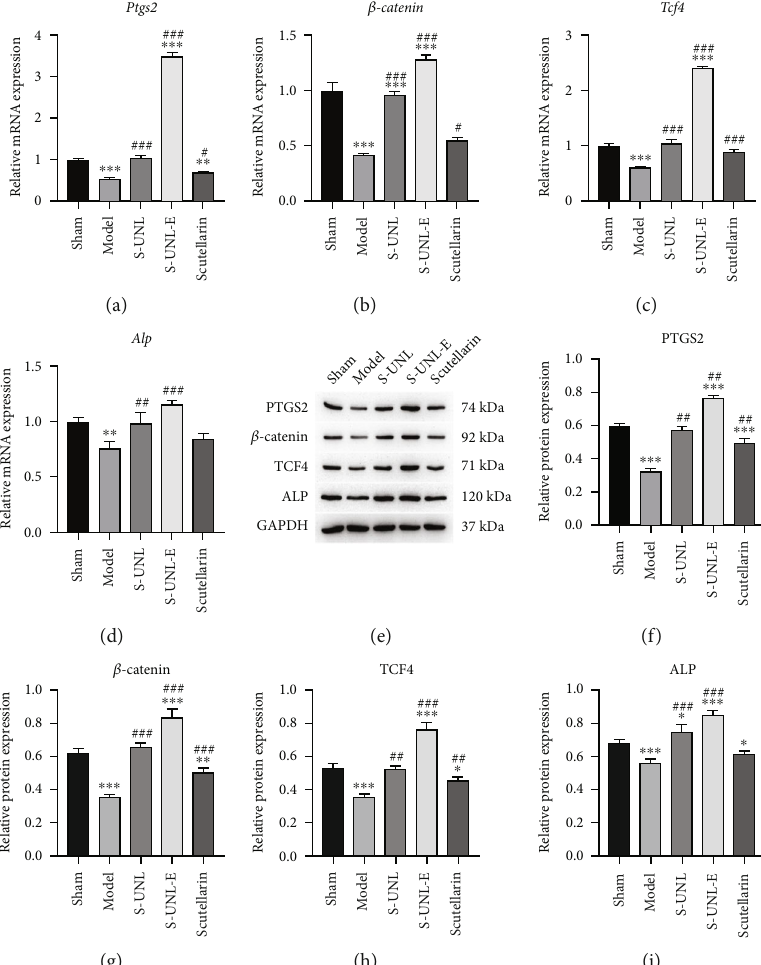
Figure 6: Relative mRNA and protein expressions of PTGS2, β -catenin, TCF4, and ALP of rats after being treated with 40mg/kg S-UNL-E. (a – d) The mRNA levels were analyzed by qRT-PCR. (e) The expression levels were analyzed by western blot. (f – i) The western blot results were quali fi ed. ∗ p < 0 : 05 , ∗∗ p < 0 : 01 , and ∗∗∗ p < 0 : 001 vs. sham. # p < 0 : 05 , ## p < 0 : 01 , and ## p < 0 : 001 vs.